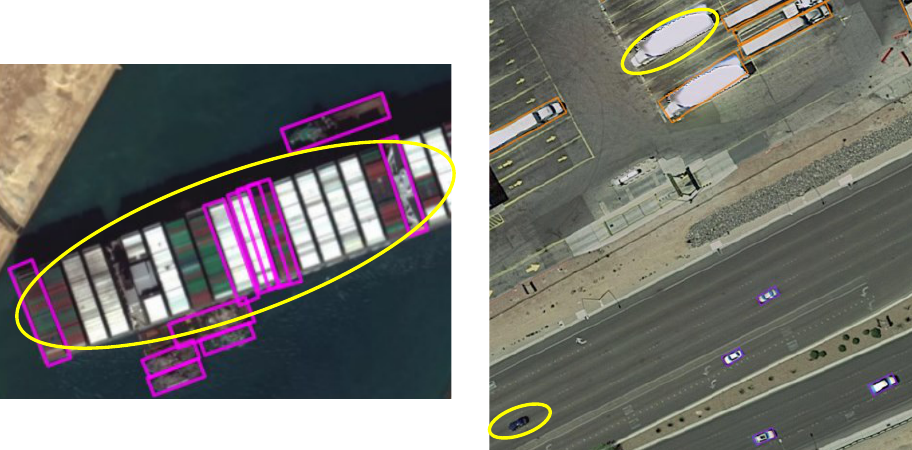
Figure 10. Failure cases for ship detection and small vehicle. Failures are marked by yellow